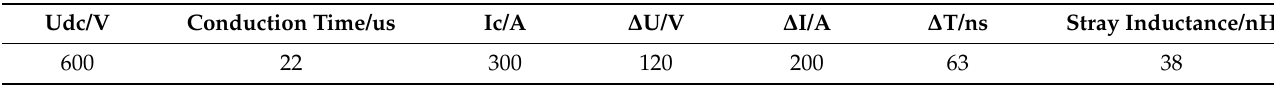
Table 4. Stray inductance test data of bus.